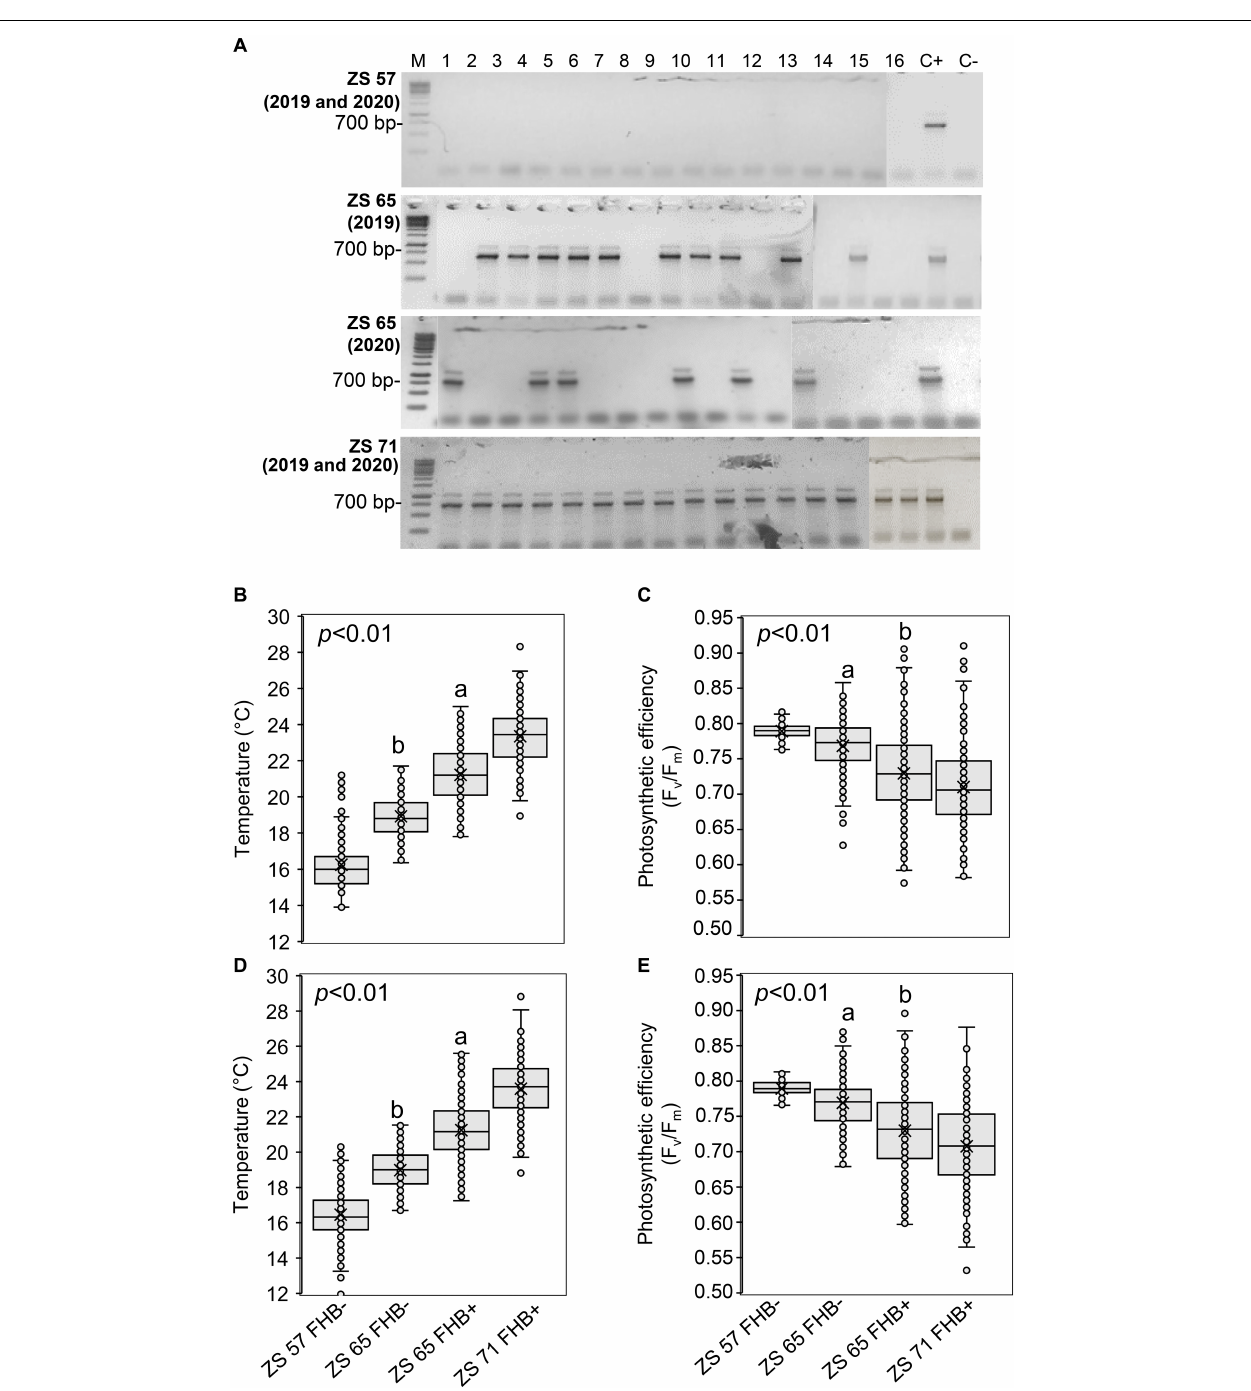
Frontiers in Plant Science |